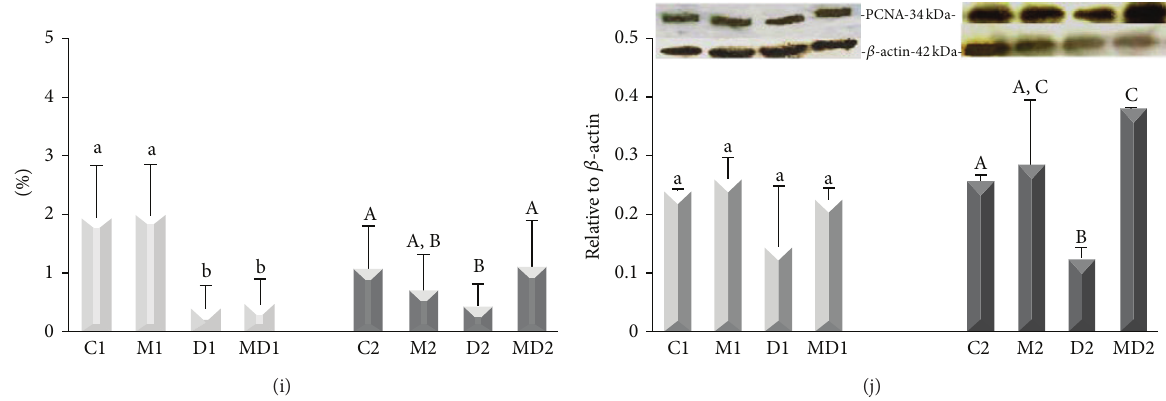
Figure 3: Proliferation index, evaluated by immunocytochemistry for proliferating cell nuclear antigen (PCNA) and Western blotting. (a) Short-term control (C1); (b) short-term control treated with MLT (M1); (c) short-term untreated diabetic (D1); (d) short-term diabetic treated with MLT (MD1); (e) long-term control (C2); (f) long-term control treated with MLT (M2); (g) long-term untreated diabetic (D2); (h) long-term diabetic treated with MLT (MD2). e: epithelium; l: lumen; s: stroma; arrow: PCNA-positive cells (brown nuclei). Magnification: 400x, bar = 25 𝜇 m. (i) Relative frequency (%) of PCNA-positive cells. (j) Western blotting for PCNA in ventral prostate extracts and the respective densitometry analysis. 𝛽 -actin was used as internal control loading. Light bars: short-term experiment and dark bars: long-term experiment ( 𝑁 = 5 animals/group). Different lowercase letters indicate significant differences between experimental groups C1, M1, D1, and MD1 (parametric data: PCNA protein content; nonparametric data: frequency of PCNA-positive cells), and different capital letters indicate significant differences between groups C2, M2, D2, and MD2 (parametric data: PCNA protein content; nonparametric data: frequency of PCNA-positive